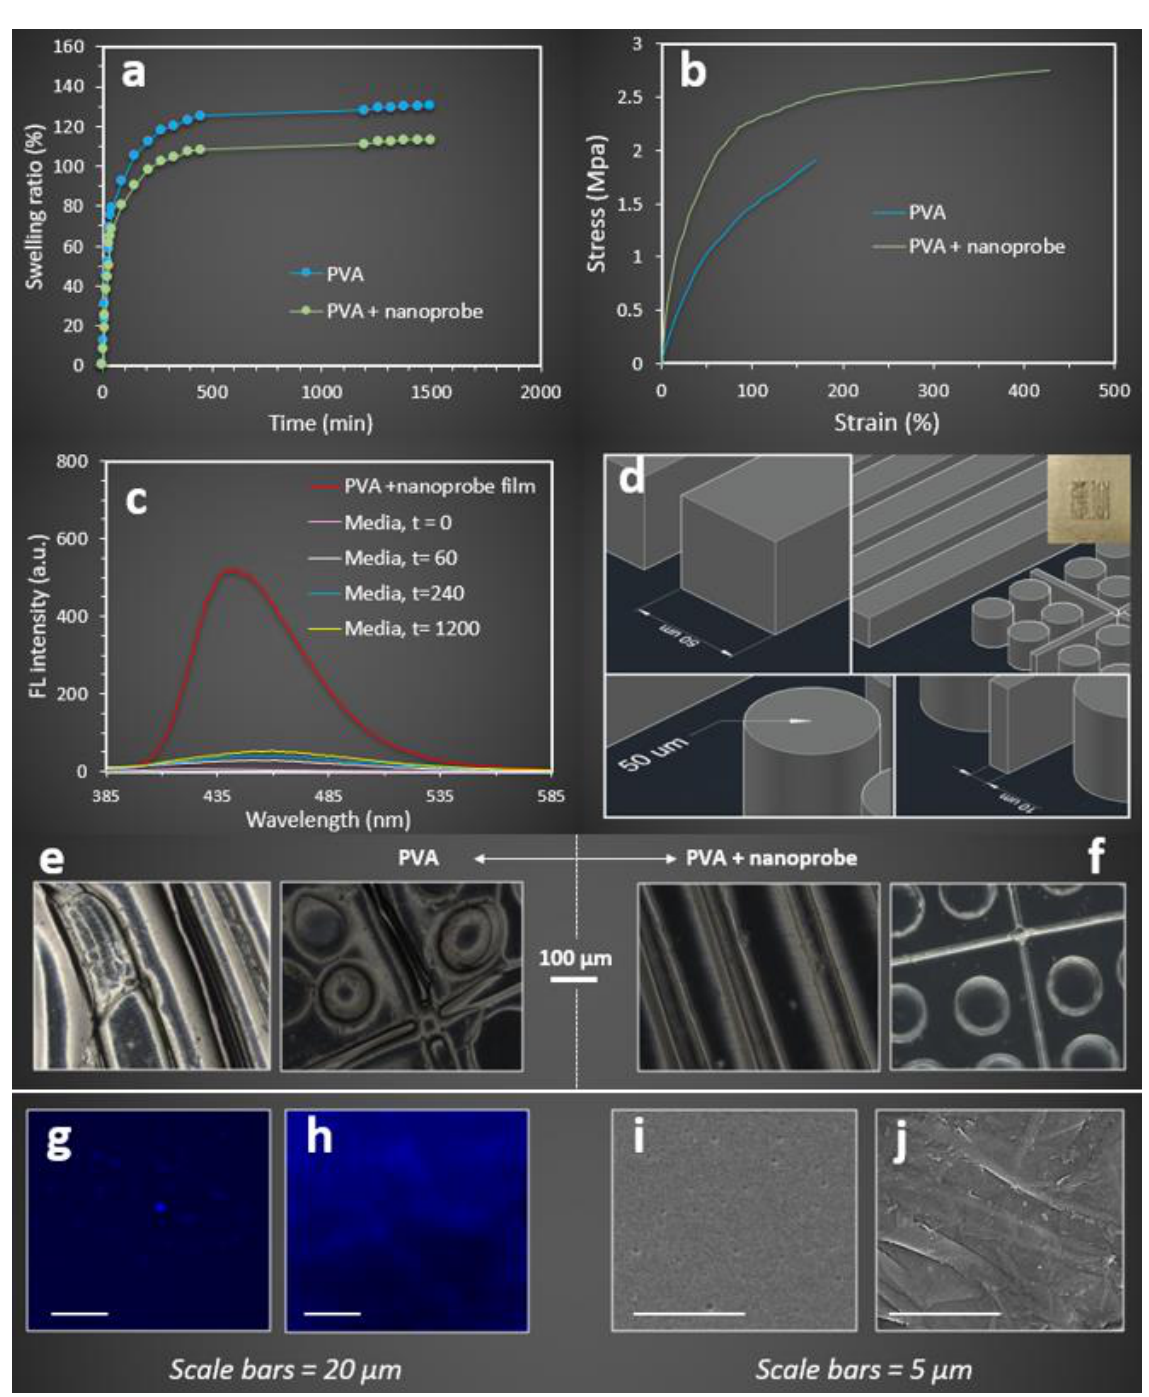
Figure 7. ( a ) Swelling and ( b ) mechanical properties of PVA and PVA + nanoprobe microchip. ( c ) Fluorescent spectra were collected from the PVA + nanoprobe microchip and swelling media (at different time steps) to quantify nanoprobe leakage during swelling. ( d ) SolidWorks drawings